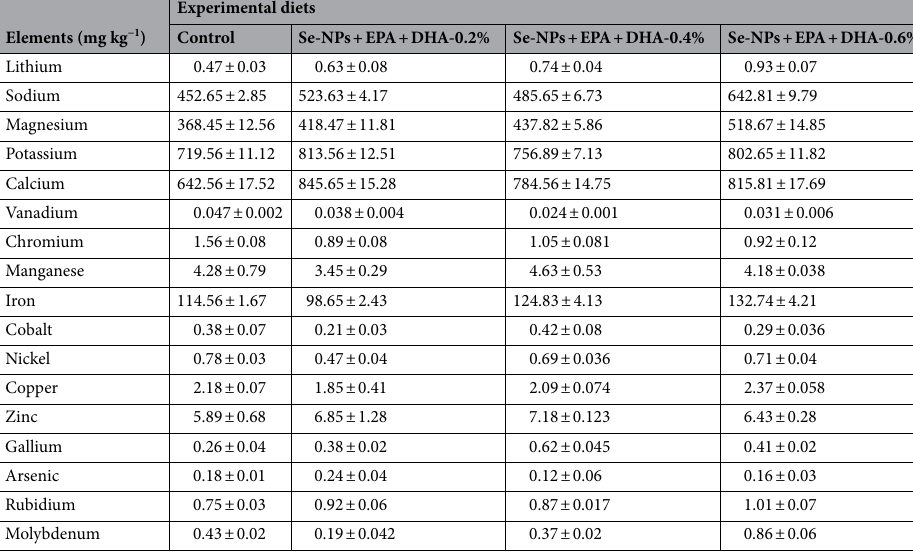
Table 9. Mineral profiling of experimental diets. Data expressed as Mean ± SE (n = 3). Unit: mg kg −1 of